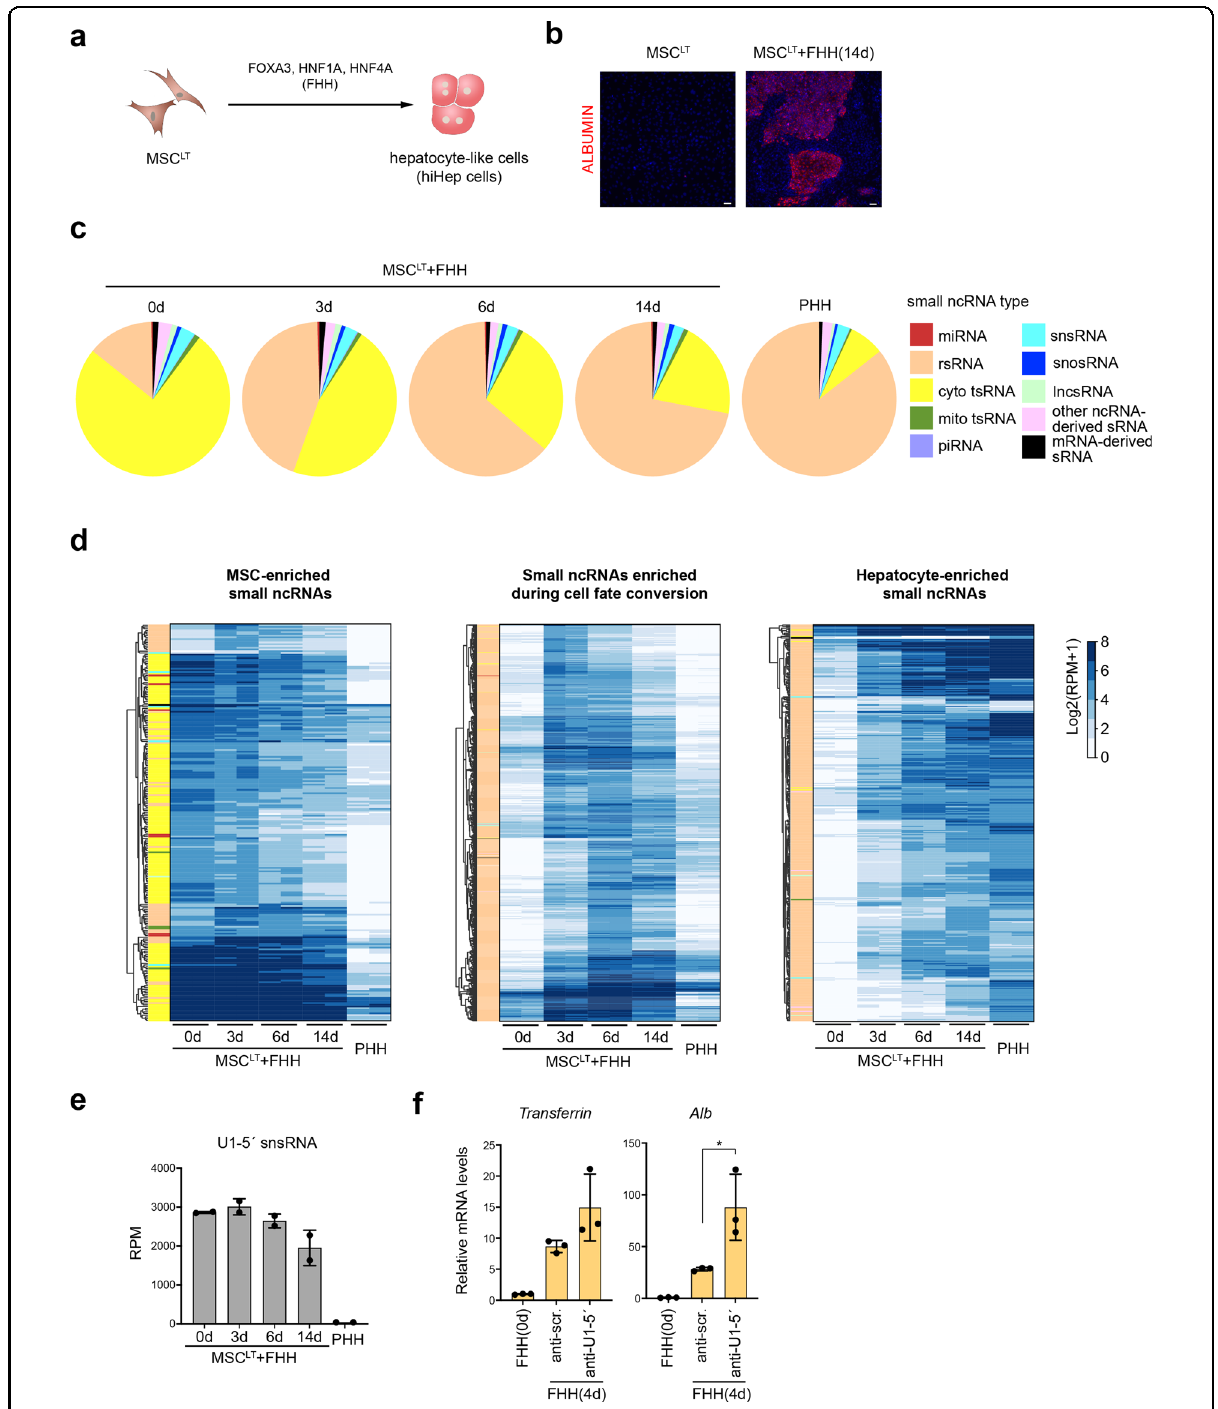
Fig. 7 Reprogramming of sRNomes during hepatic reprogramming. a Schematic illustration of the strategy used for direct conversion of human MSC LT to hepatocytes. b Fluorescent immunostaining of MSC LT and MSC LT infected with FOXA3 , HNF1A , and HNF4A (FHH) for 14 days. Scale bar: 100 μ m. c Distribution of different types of sRNAs in PHH and MSC LT infected with FHH. d Hierarchical clustering of unique reads (RPM > 20 in at least one sample) from sequenced samples showing the decreased expressions of MSC LT -enriched sRNAs and increased expression of PHH-enriched sRNAs during hepatic reprogramming. e Differential expression levels of U1-5 ′ snsRNA in MSC LT and PHH. The expression levels of U1-5 ′ snsRNA gradually decreased in MSC LT cells infected with FHH. f Treatment of U1-5 ′ ASO promoted the induction of hepatic marker genes in MSC LT cells overexpressing